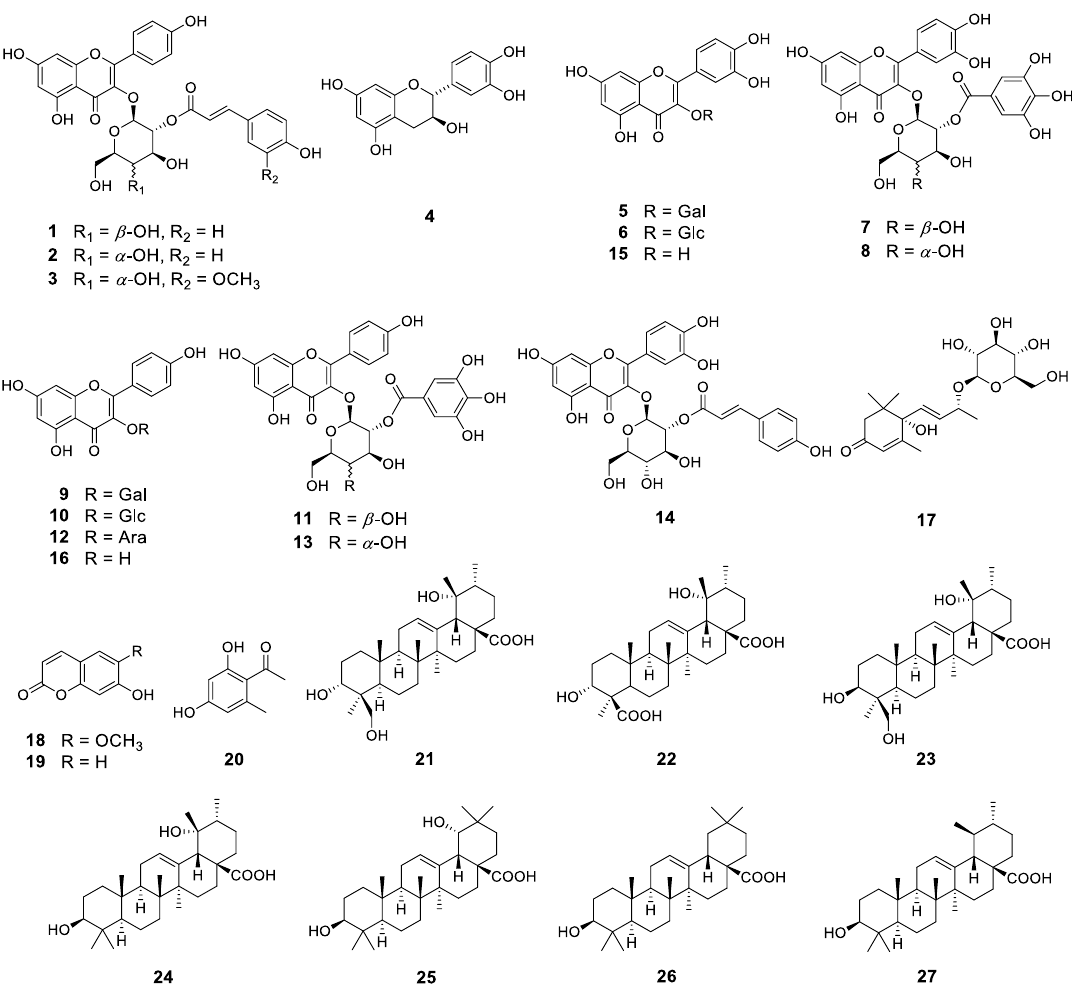
Figure 1. DPPH scavenging effects of the EtOH extract ( A ), EtOAc layer ( B ), and H 2 O layer ( C ) H 2 O layer of the persimmon leaves; ( D ) online ABTS-HPLC chromatogram of the EtOH extract.